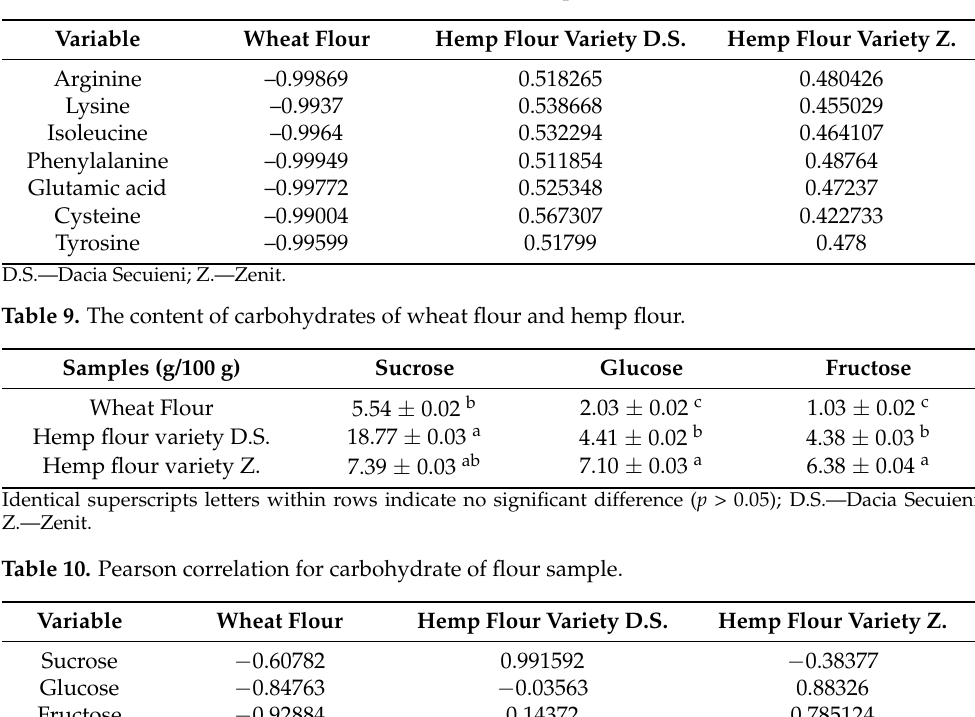
Table 8. Pearson correlation for amino acids of flour sample. Variable Wheat Flour Hemp Flour Variety D.S. Hemp Flour Variety Z.